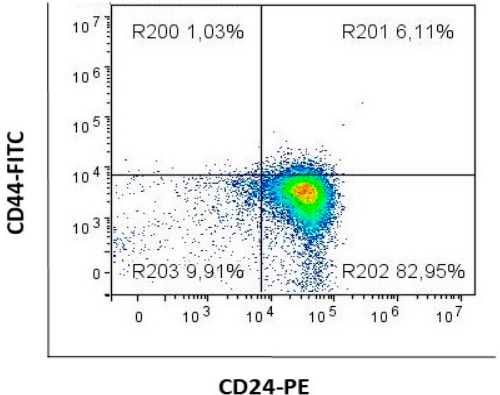
Figure 2. Gating strategy. Notes: representative dot plot of gating CD44 + CD24 − (gate R200),